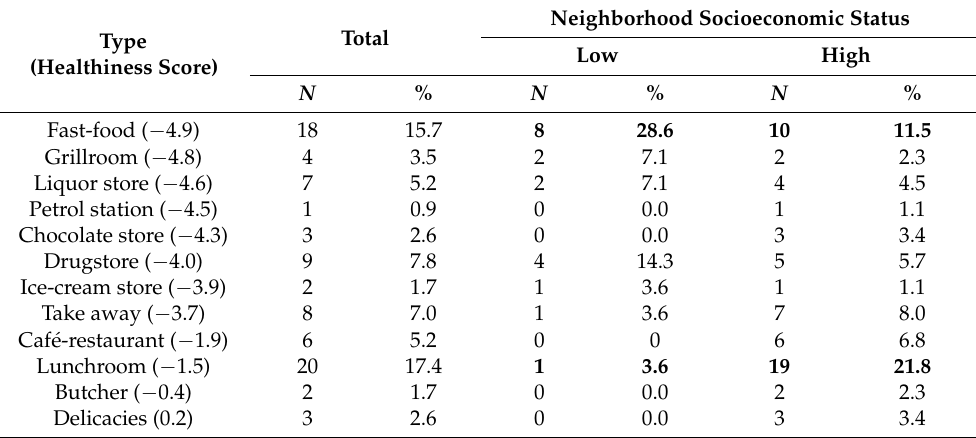
Table 1. Retail outlets in 400-m buffers surrounding secondary schools in the municipality of Utrecht, the